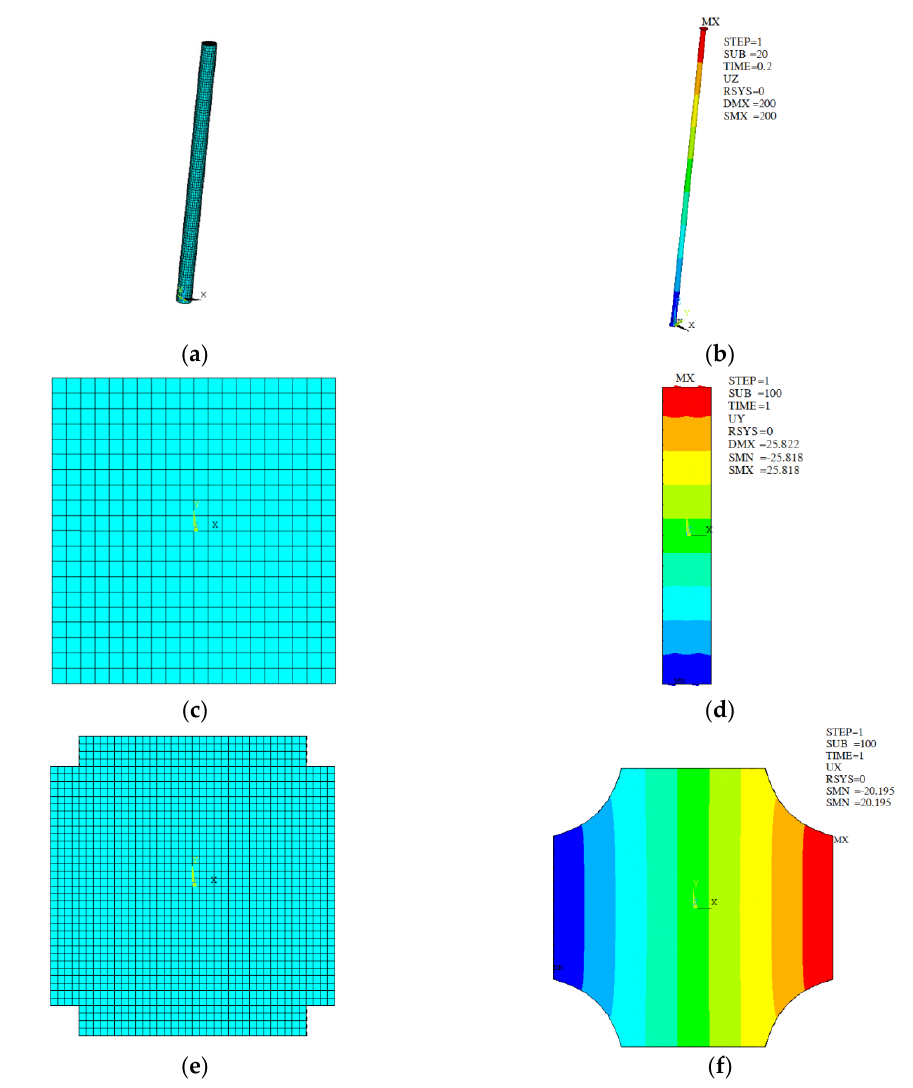
Figure 2. The FE (finite element) models for numerical verification: ( a )initial model of uniaxial tension experiment; ( b ) deformed model of uniaxial tension experiment ( λ = 5); ( c ) initial model of planar tension experiment; ( d ) deformed model of planar tension experiment ( λ = 6.164); ( e ) initial model of of biaxial tension experiment; ( f ) deformed model of biaxial tension experiment ( λ =